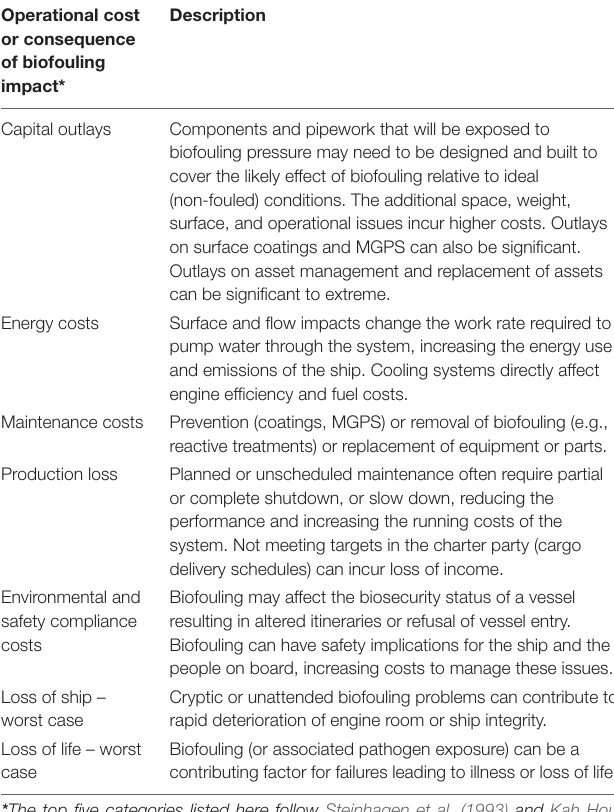
TABLE 2 | Consequence of operational impacts of biofouling within ships’